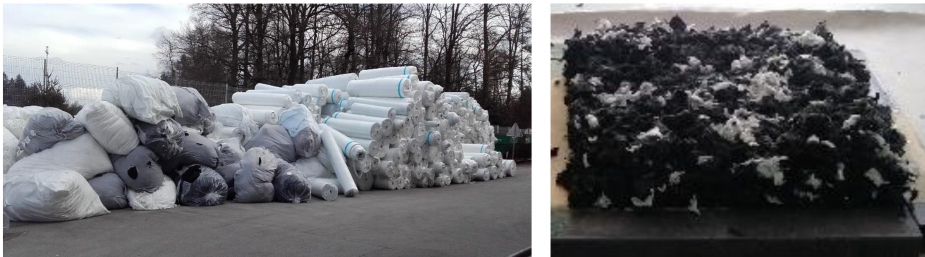
Figure 1. The discarded nonwoven polyester textile at the company’s waste storage ( left ) and shred- ded waste polyester nonwoven textile prepared for further processing and manufacturing ( right